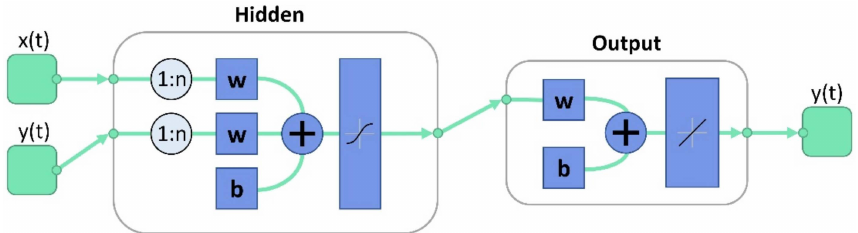
Figure 10. Conceptual design of the electric power prediction model developed in MatLab (x(t)—input data; y(t)—output data; w—weight; b—bias; 1:n—input delay